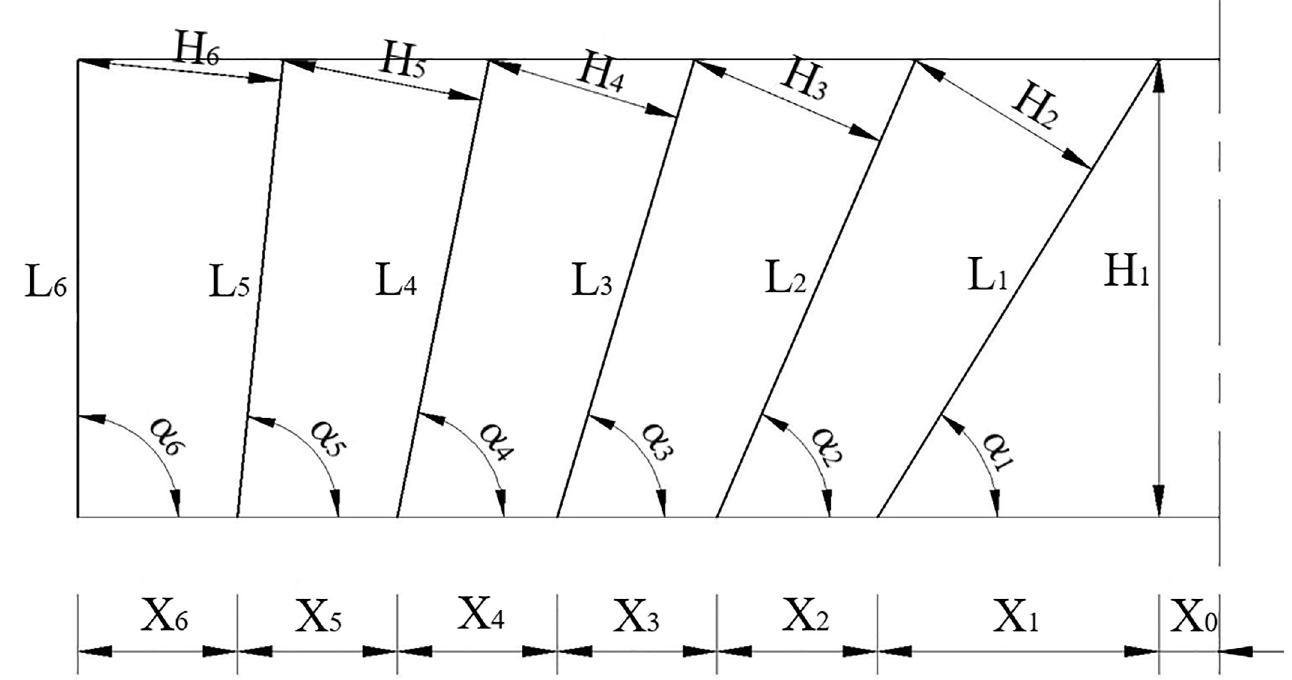
Fig 4. Layout of different blast holes of the A-A tunnel